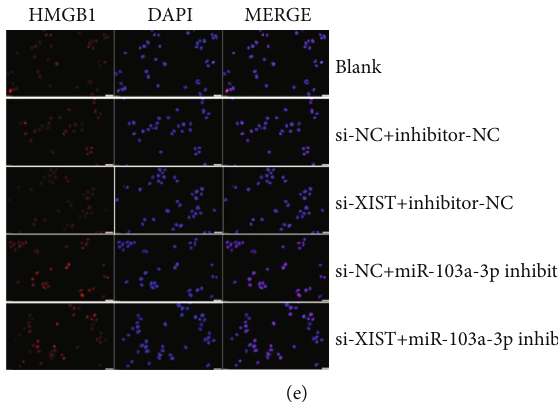
Figure 3: The expression of HMGB1 sponged by miR-103a-3p was improved by adding lncRNA XIST to sponge miR-103a-3p. (a) Bioinformatic analysis using ENCORI database shows the interaction of miR-103a-3p with HMGB1, and the binding relationship of miR-103a-3p and HMGB1 was proved by luciferase reporter gene assays. (b) The expression of miR-103a-3p in transfected HUVECs was detected by qRT-PCR. (c) The expression of HMGB1 in cotransfected cells was analyzed by qRT-PCR. (d) The expression level of HMGB1 protein in cotransfected cells was analyzed by western blot. (e) The expression level of HMGB1 protein in cotransfected cells was detected by immuno fl uorescence analysis (scale bar: 20 μ m). The nontrasfected HUVECs served as the blank group. ∗ P < 0 : 05 and ∗∗ P < 0 : 01